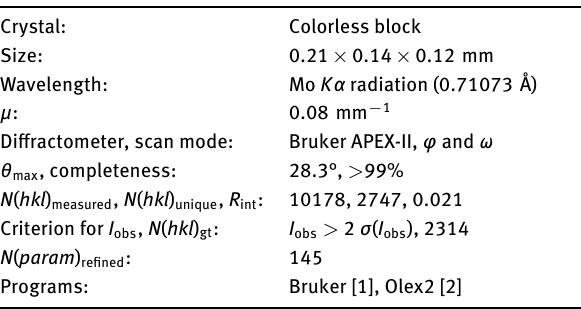
Table 1: Data collection and handling.